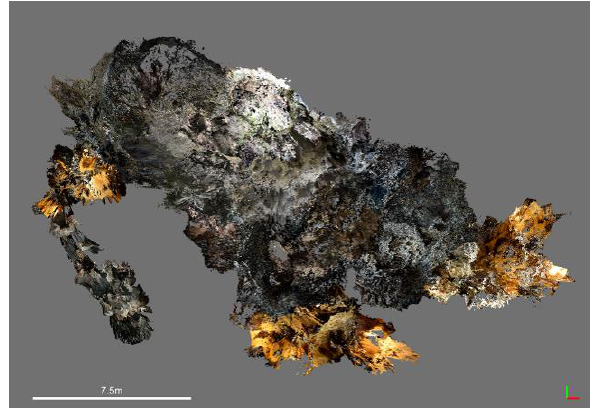
Figure 3 – The internal 3D model of the La Sassa cave (point